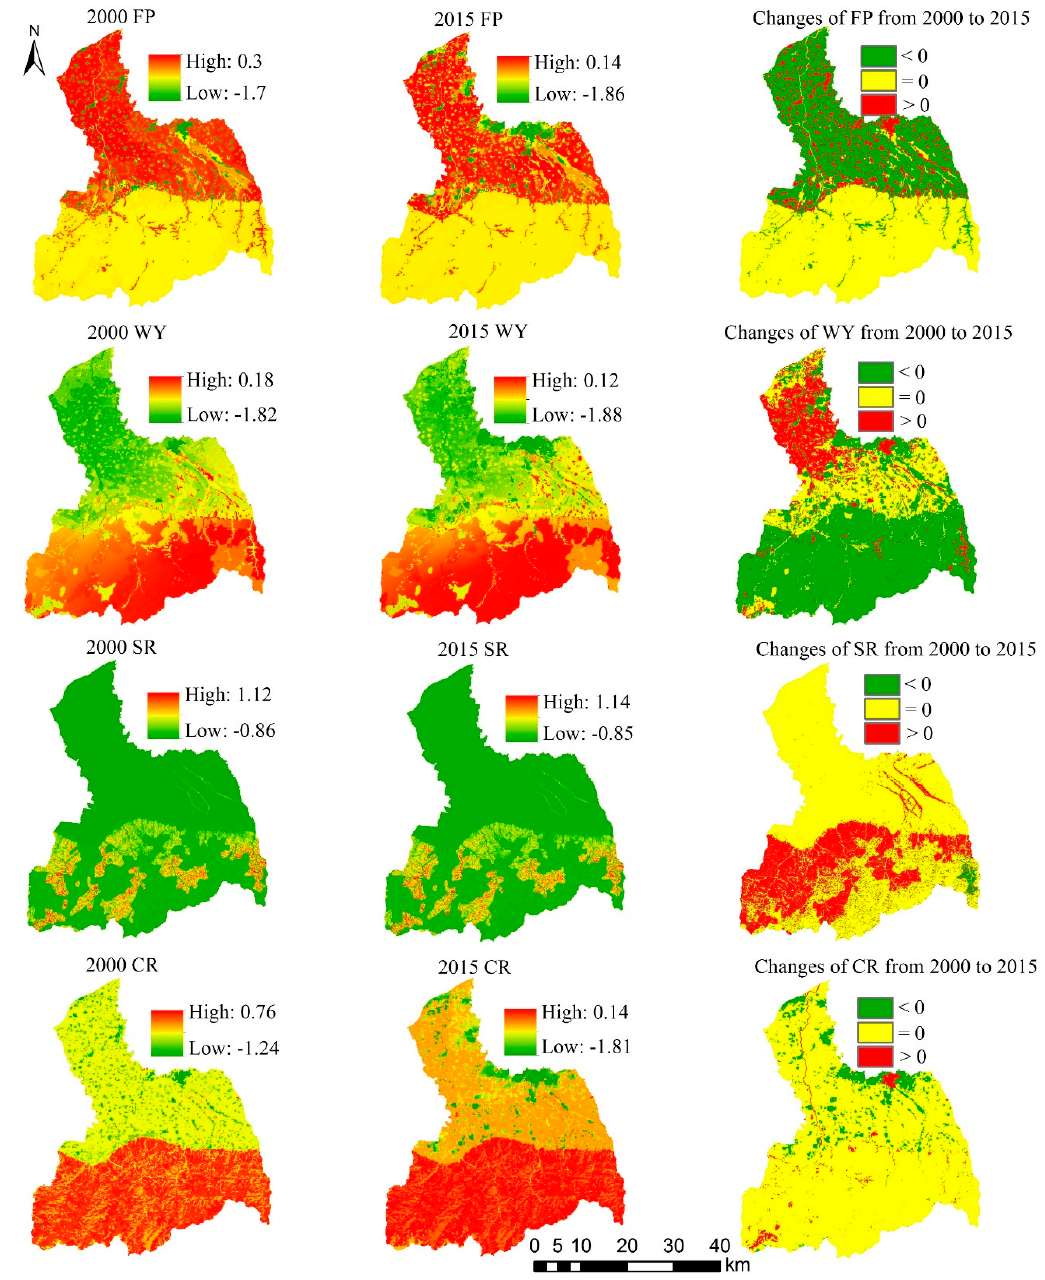
Figure 12. The spatial distribution and spatiotemporal change of the supply–demand ratio in grid-scale. Table 3. The mean of supply–demand ratio for four ES in the FRW.